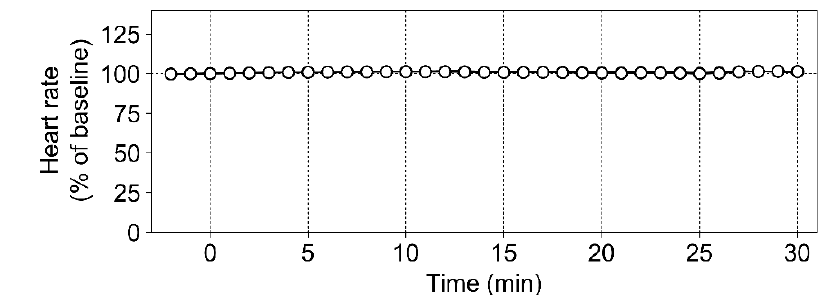
Figure 5. Involvement of prostanoid IP receptors in intravenous infusion of prostaglandin I 2 (PGI 2 )- induced retinal arteriolar dilation in rats. The upper, middle, and bottom panels show the effect of CAY10441 (10 nmol/eye) on changes in retinal arteriolar diameter, mean arterial pressure, and heart rate induced by intravenous infusion of PGI 2 (0.03–10 µg/kg/min), respectively. Each point with a vertical bar represents the mean ± S.E.M. from four animals. * p < 0.05.